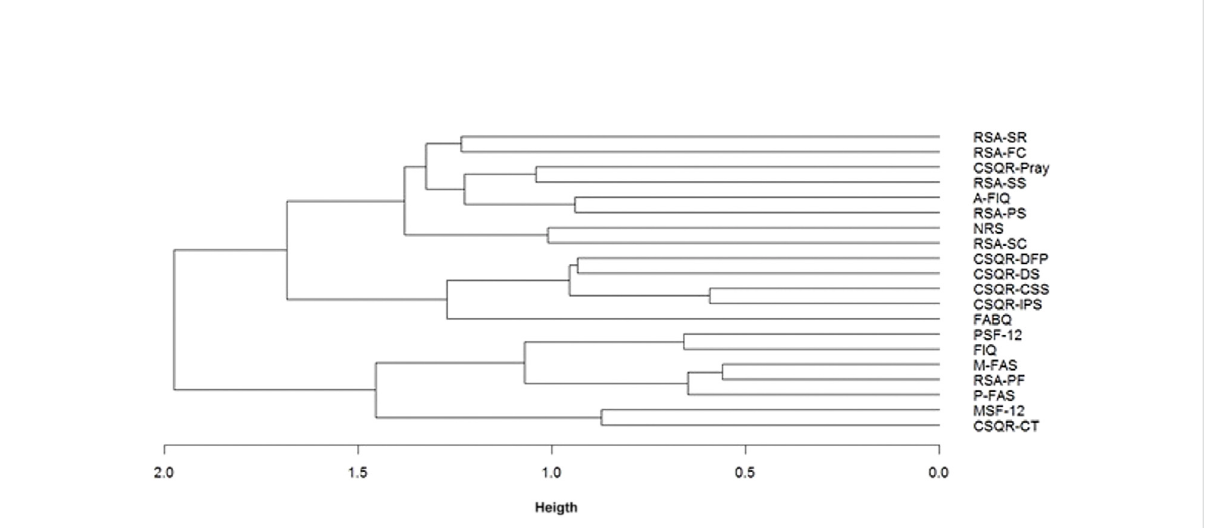
FIGURE 2 Dendrogram clustering of scales of physical distress and fear, physical and mental disability, resilience and coping ability. NRS = numeric rating scale; P-FAS = physical fatigue assessment scale; M-FAS = mental fatigue assessment scale; FABQ = fear avoidance belief questionnaire; FIQ = fi bromyalgia impact questionnaire; A-FIQ = anxiety fi bromyalgia impact questionnaire; PSF-12 = physical 12-Item short form survey; MSF-12 = mental 12-item short form survey; RSA = resilience scale for adults (subscales: PS = perception of self; PF = planned future; SC = social competence; SS = structured style; FC = family cohesion; SR = social resources); CSQR = coping strategies questionnaire-revised (subscale: DS = distraction; CT = catastrophizing; IPS = ignoring pain sensations; DFP = distancing from pain; CSS = coping self-statements; Pray =